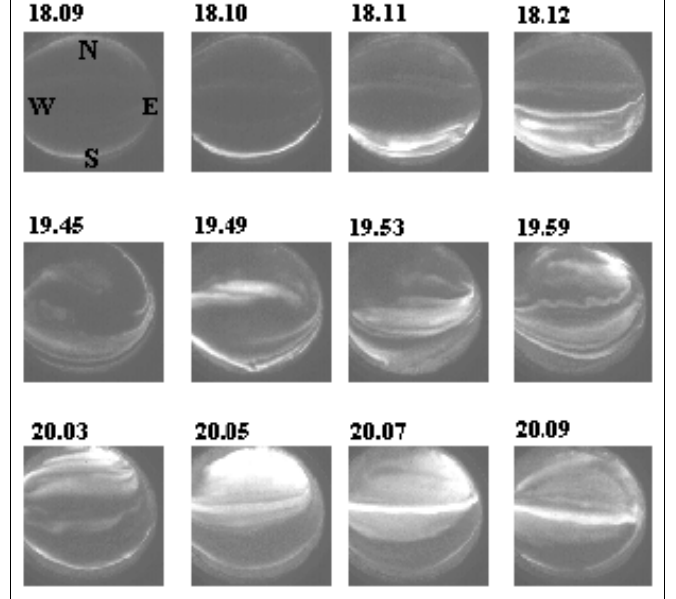
Fig. 3. ASC frames recorded at the sta- tion ABK around the times of the auro- ral intensifications (18:10UT, 19:48UT and